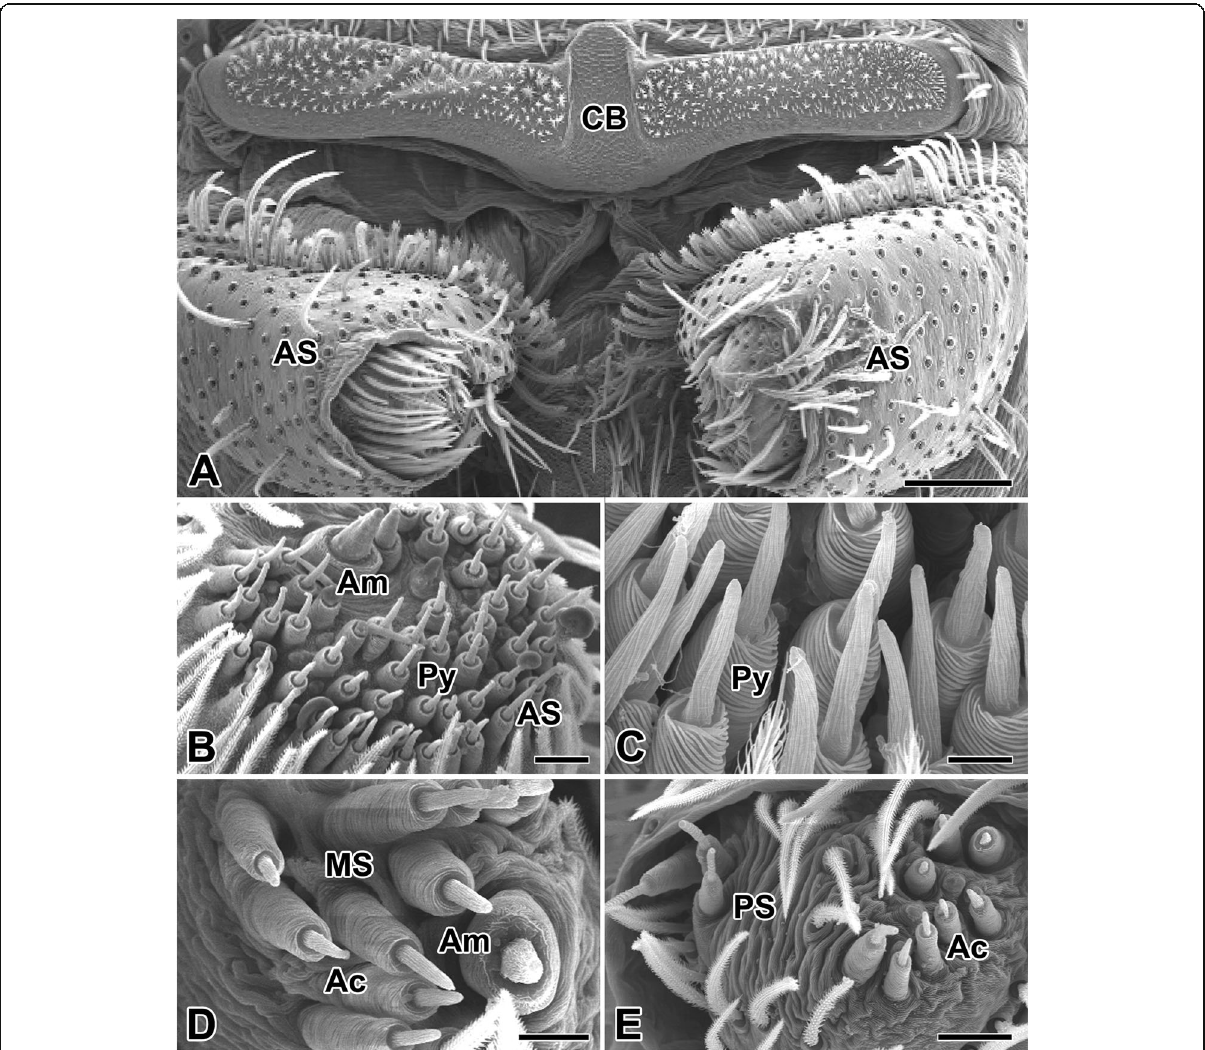
Fig. 1 Scanning electron micrographs of the cribellum and spinnerets in the spider N. albofasciata . a Cribellum (CB) is located at the upper region of the anterior spinnerets (AS). b, c On the anterior lateral spinneret, the major ampullate gland (Am) and the pyriform gland (Py) spigots were observed. d On the posterior median spinneret (MS) the minor ampullate gland and the aciniform gland (Ac) spigots were distributed. e On the posterior lateral spinnerets (PS), spigots of the aciniform glands are seen. Scale bars indicate 100 μ m ( a ), 20 μ m ( b, e ), 10 μ m ( d ), and 5 μ m ( c ),